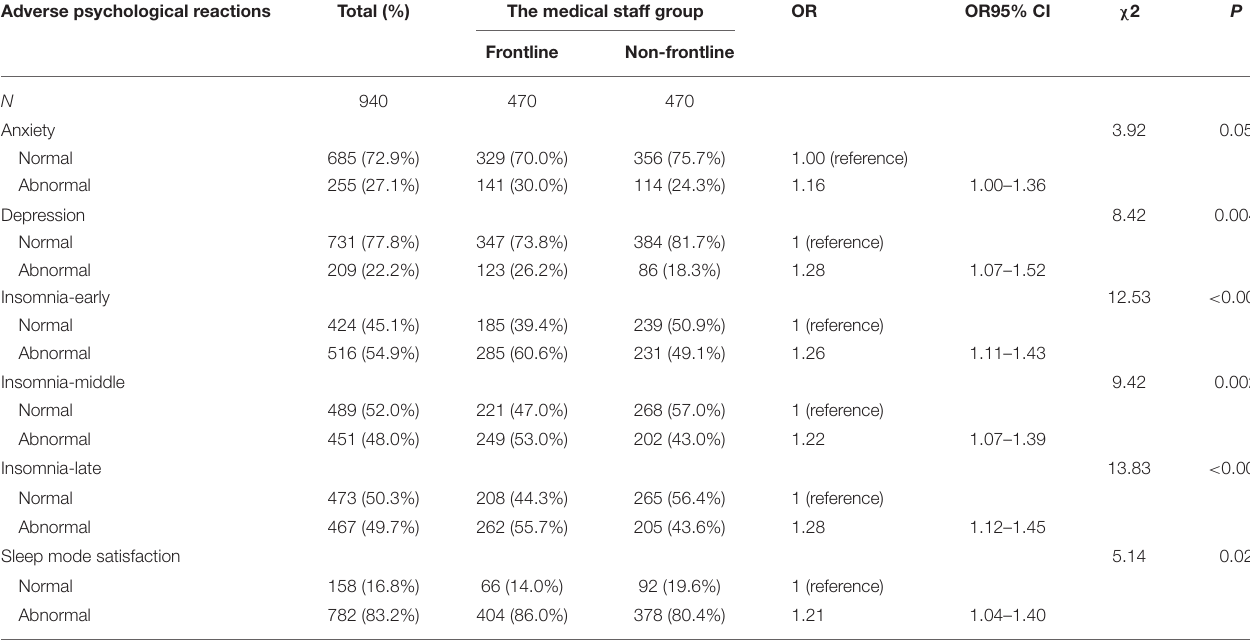
TABLE 2 | Comparisons of the symptoms of adverse psychological reactions between frontline and non-frontline groups after PSM. Adverse psychological reactions Total (%) The medical staff group OR OR95% CI χ